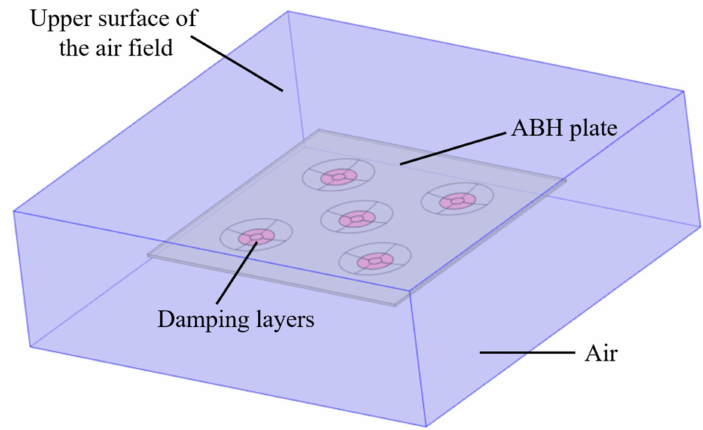
Figure 17. The acoustic-ABH plate coupling model.